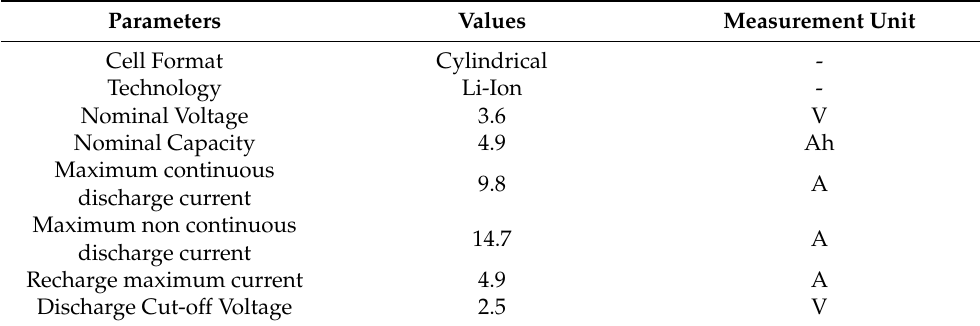
Table 1. Technical specifications of SAMSUNG INR21700-50E cell as reported on Samsung company datasheet [20].